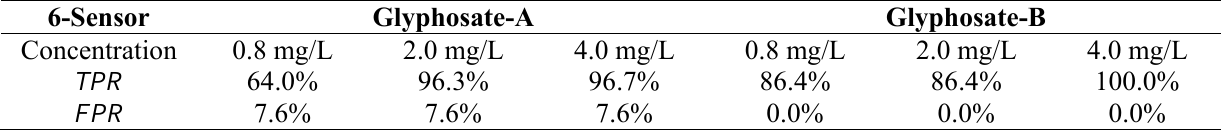
Figure 6. The optimization results for glyphosate-A series with six sensors. Table 5. The TPR and FPR performances of glyphosate-A and glyphosate-B series.